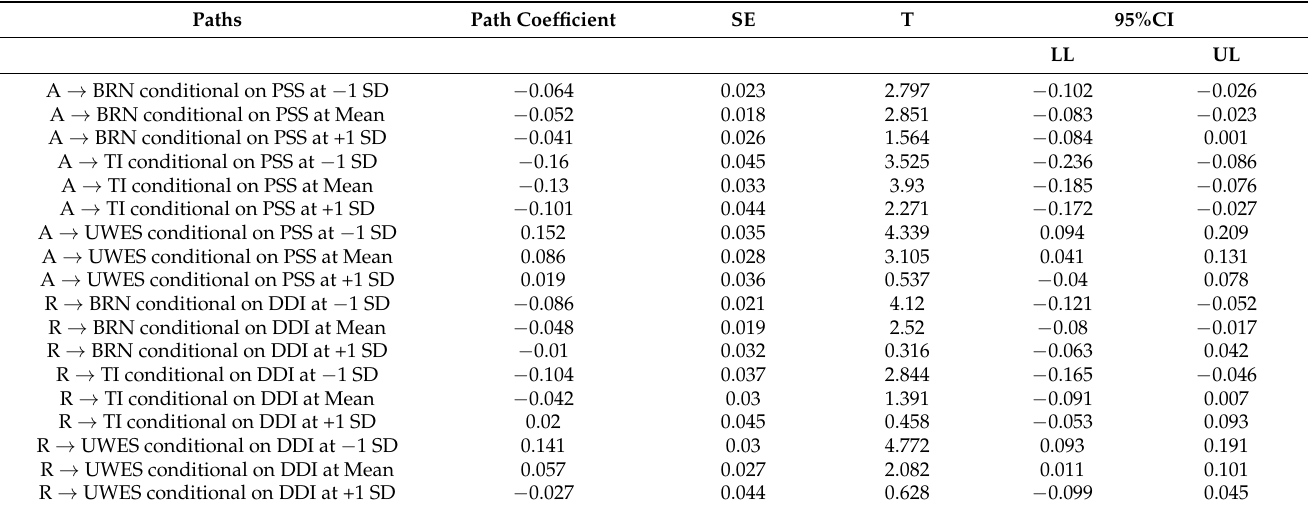
Table A11. Moderation Analyses—Conditional Direct